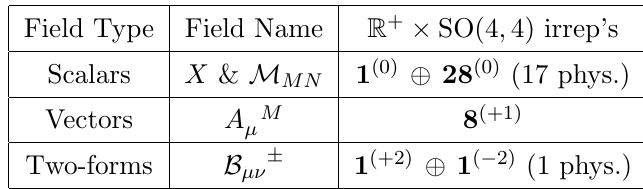
Table 6 . The (bosonic) (cid:12)eld content of half-maximal supergravity in six dimensions. (cid:22) denotes a spacetime index, M is a MW spinor of SO(4 ; 4). Note that the degrees of freedom of the two-form are halved by means of a self-duality